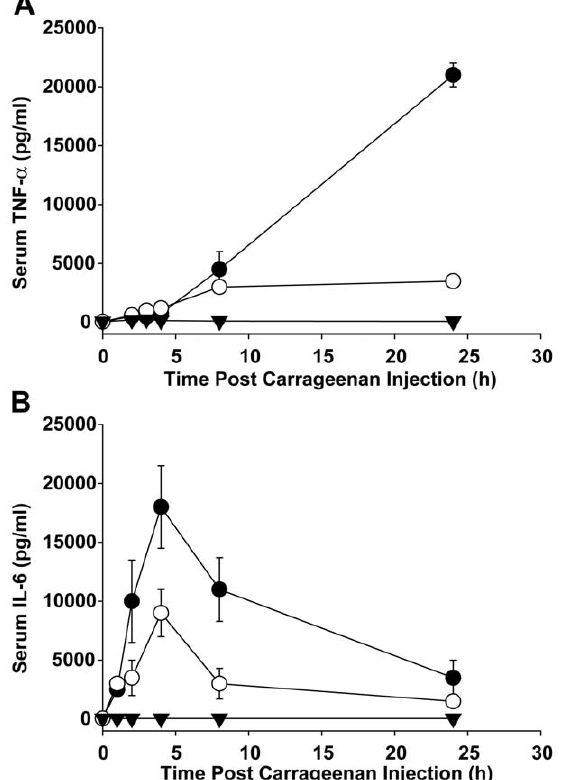
Figure 2. Inhibition of serum TNF- a and IL-6 levels in murine DIC model by MN10021. Each of 5 groups of 5 CD-1 mice (male, 6– 8 weeks of age) were injected i.p. with 0.25 ml of either saline (solid inverted triangles), 1.0 mg (245 nmol) MN20050 in saline (closed circles), or 1.0 mg (245 nmol) MN10021 in saline (open circles). Eighteen hours later the MN20050 and MN10021 groups were injected i.p. with